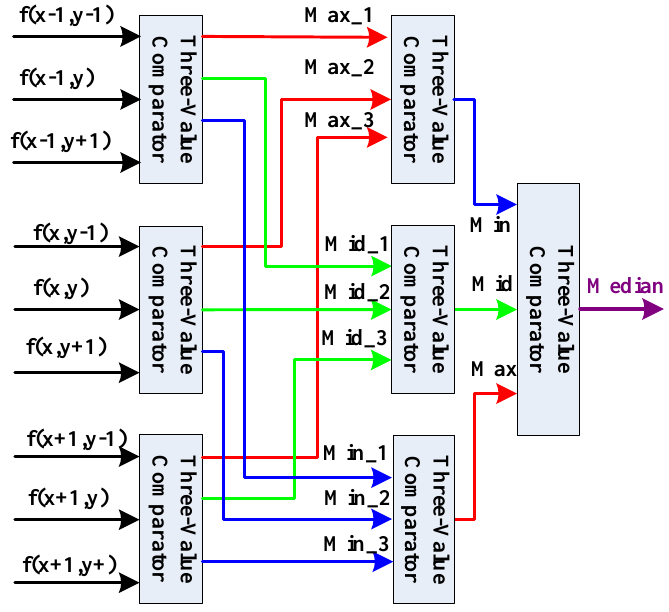
Figure 6. Calculation architecture of parallel fast median